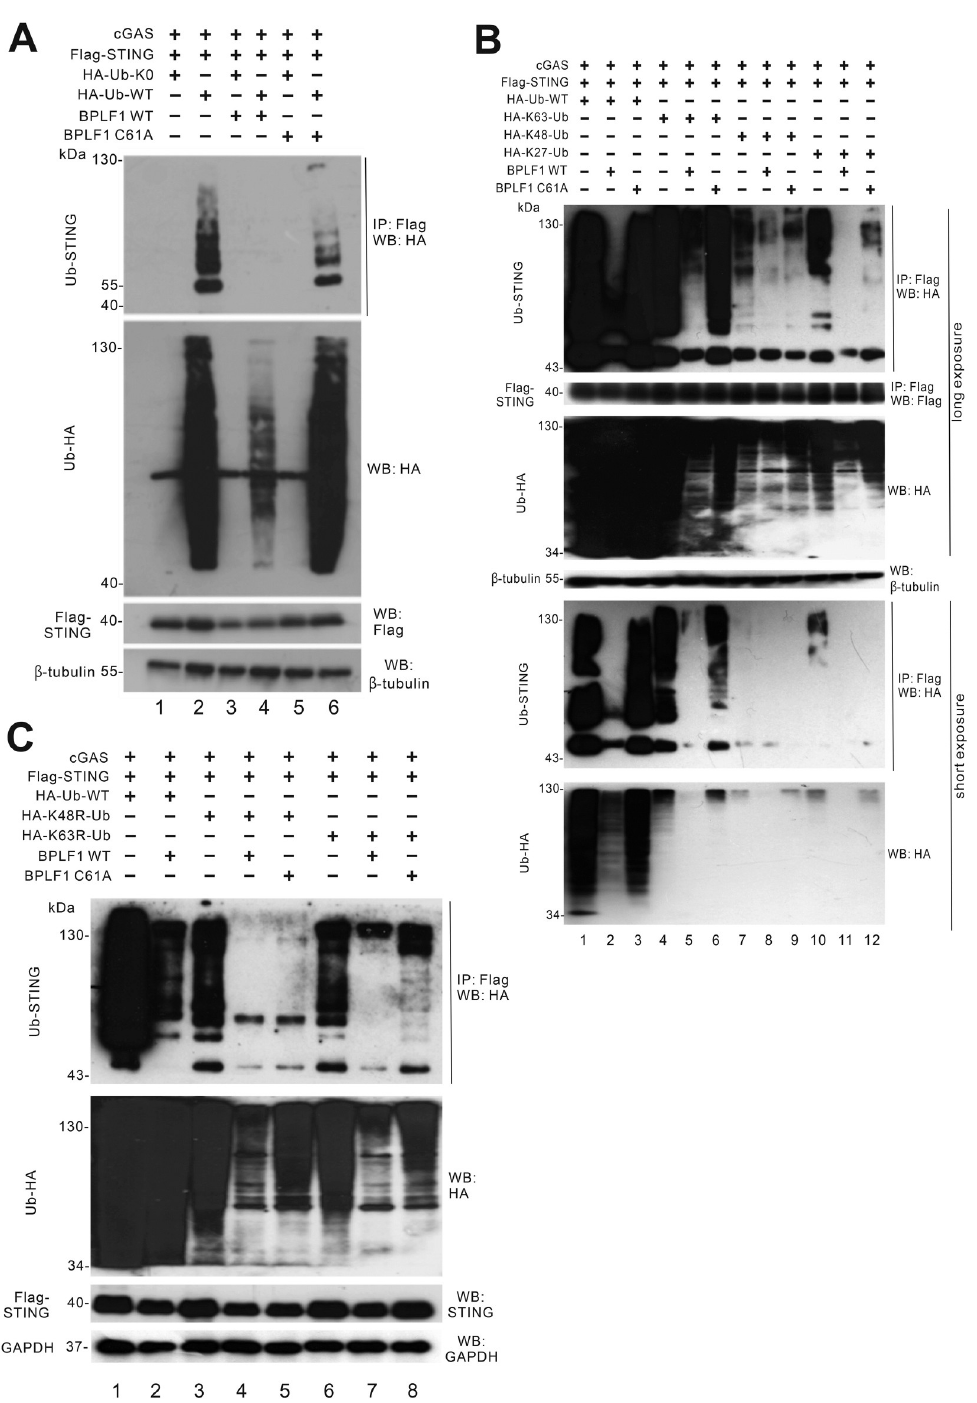
Fig 4. BPLF1 perturbs STING ubiquitination. (A) Influence of BPLF1 and C61A on STING ubiquitination. BPLF1, C61A, cGAS and STING expression plasmids were transfected into HEK293 cells together with HA-Ub-WT and HA-Ub- K0. (B) Influence of BPLF1 and C61A on STING ubiquitination of different types. BPLF1, C61A, cGAS and STING expression plasmids were transfected into HEK293T cells together with HA-Ub-WT and HA-K63-Ub, HA-K48-Ub and HA-K27-Ub. (C) Influence of BPLF1 and C61A on K48R- and K63R-linked ubiquitination of STING. BPLF1, C61A, cGAS and STING expression plasmids were transfected into HEK293T cells together with HA-Ub-WT, HA-K63R-Ub and HA-K48R-Ub. Cells were harvested 24 hours after transfection for co-immunoprecipitation. The Flag-tagged STING molecules were pulled down by anti-Flag antibodies. The bound fraction of the immunoprecipitates (IP) and the total